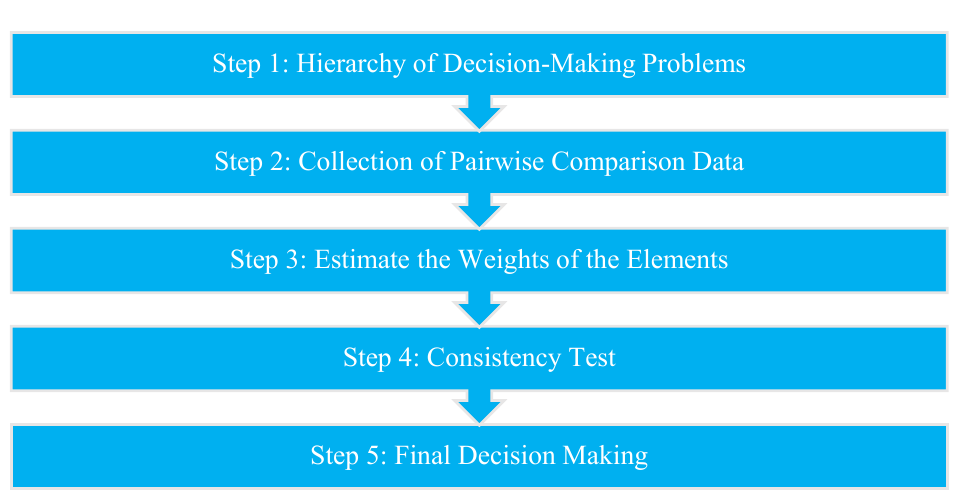
Figure 1. Decision-Making Process via AHP.